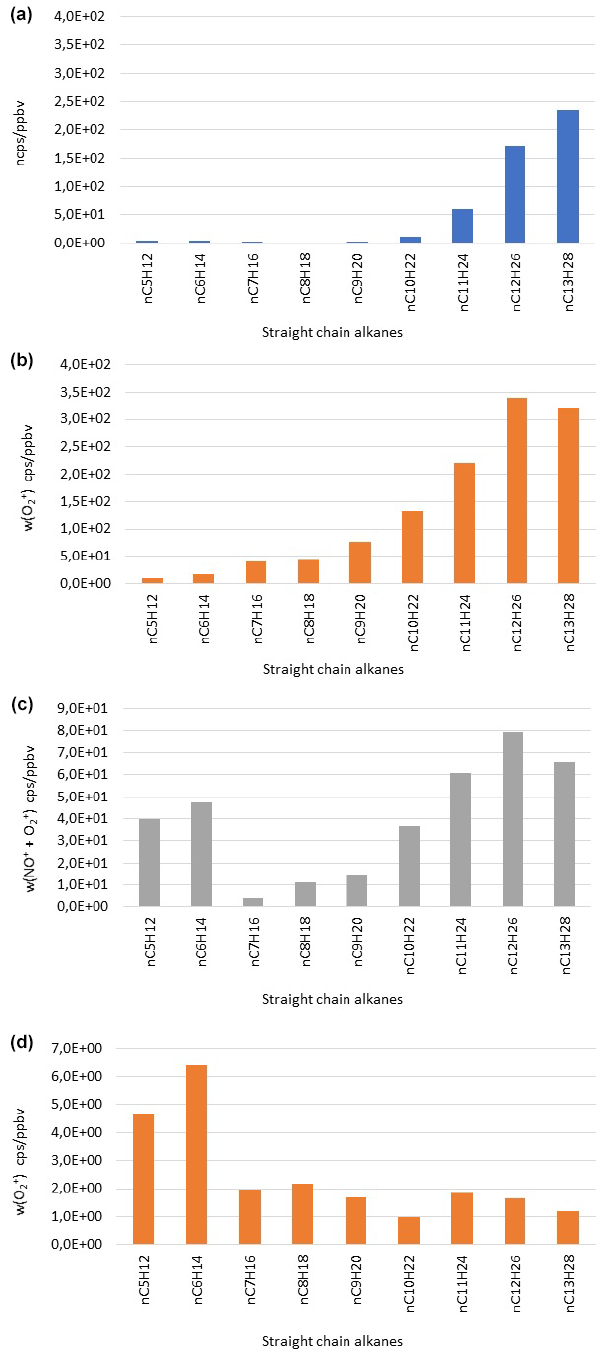
Figure 5. Sensitivities for straight chain alkanes detected by dif- ferent mechanisms: (a) proton transfer, normalized to H 3 O + ; ) ; (c) hydride ab- (b) charge transfer, weighted to sum (NO + + O + 2 ) ; (d) double hydride ab- straction, weighted to sum (NO + + O + 2 straction, weighted to O + . 2